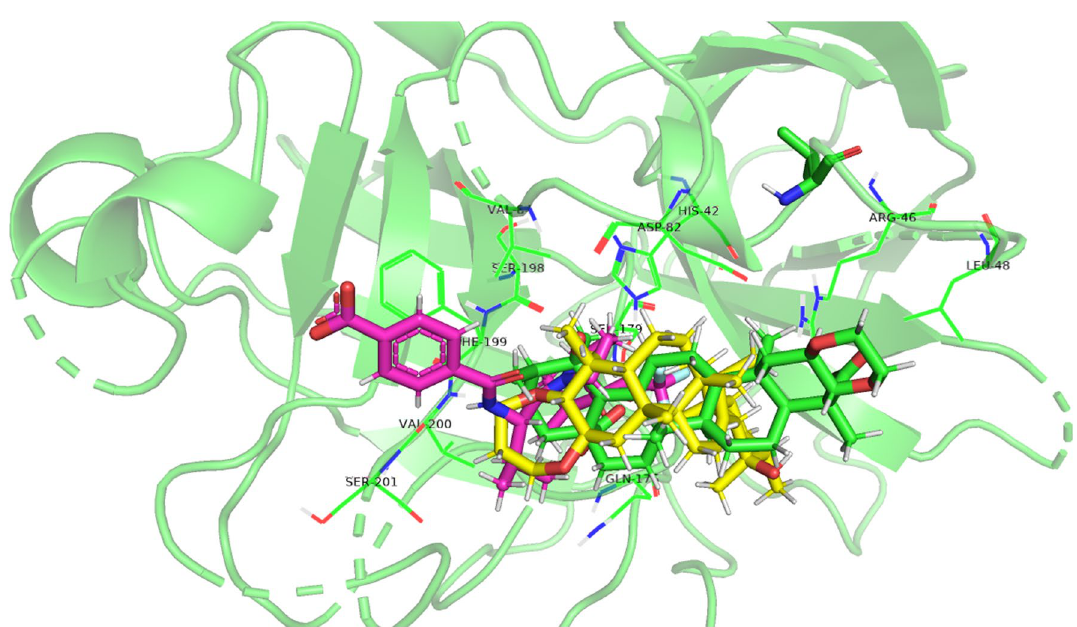
Figure 5. Visualization of elastase binding site using PyMOL. Blue = cocrystal; green = compound 1; yellow = compound